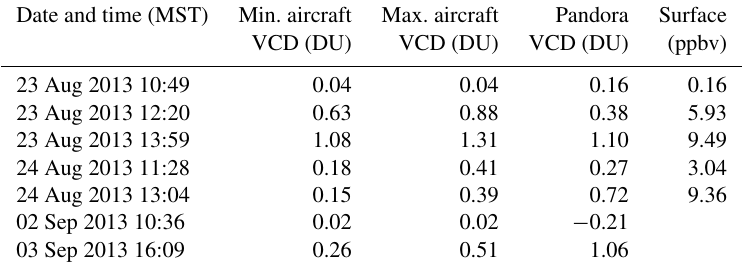
Table 1. SO 2 VCD calculated from measurements of seven aircraft flights, from Pandora 104 measurements and surface SO 2 concentrations.